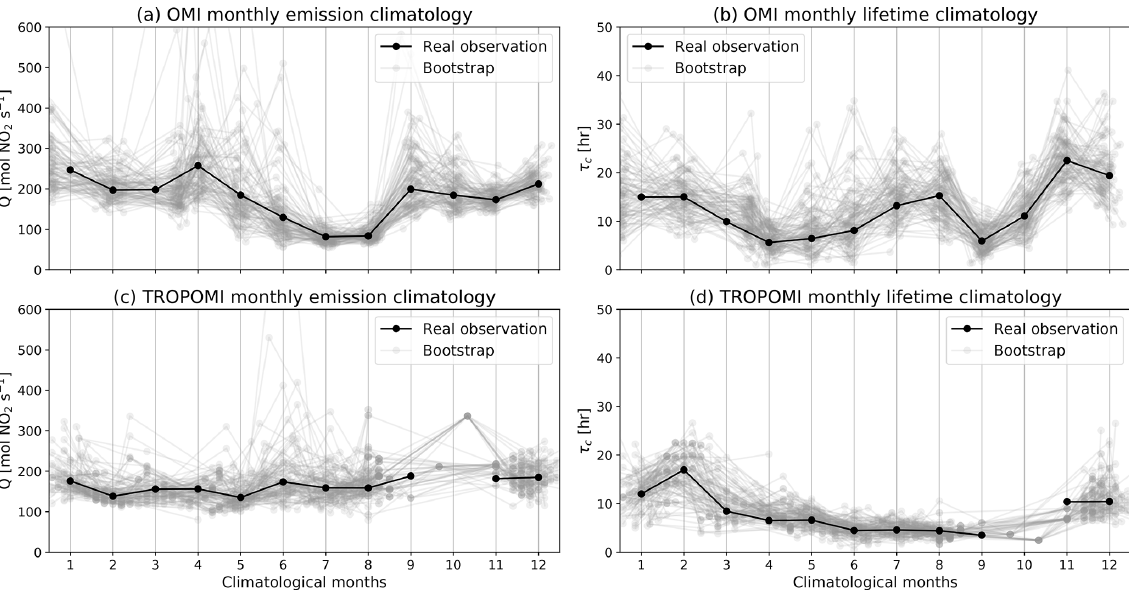
Figure 6. Similar to Fig. 4, but after outlier month exclusion shown in Fig. 5.